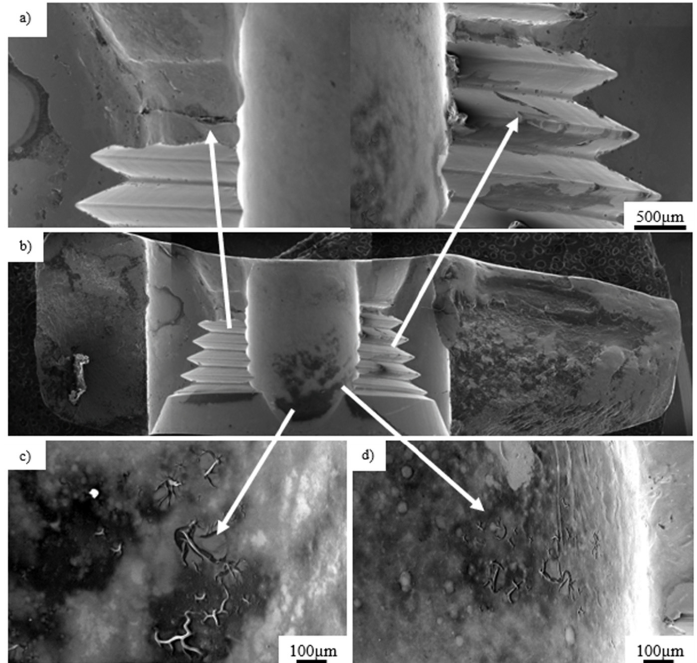
Materials 2021 , 14 , x FOR PEER REVIEW Figure 16. Microscopic observations of the inner area of the fracture surface. Figure 16. Microscopic observations of the inner area of the fracture surface.